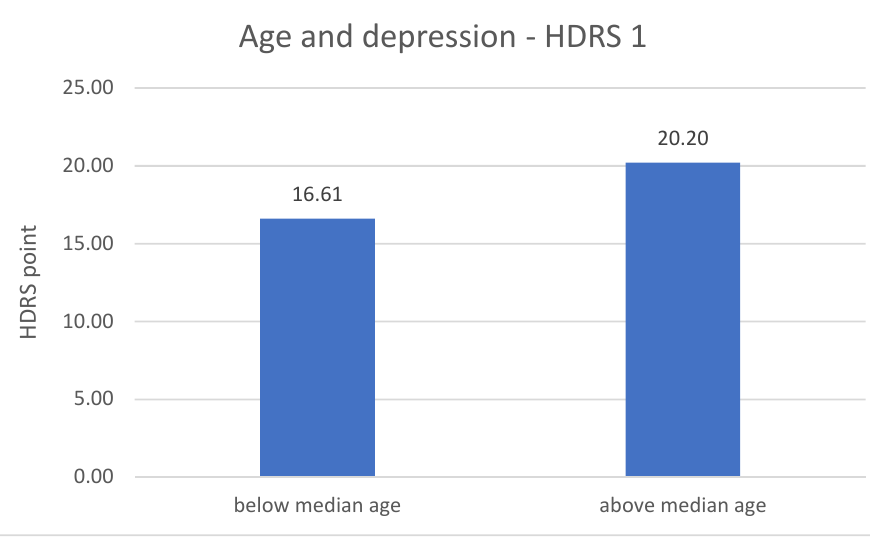
Figure 3. Age and the severity of depression—HDRS 1 measurement.